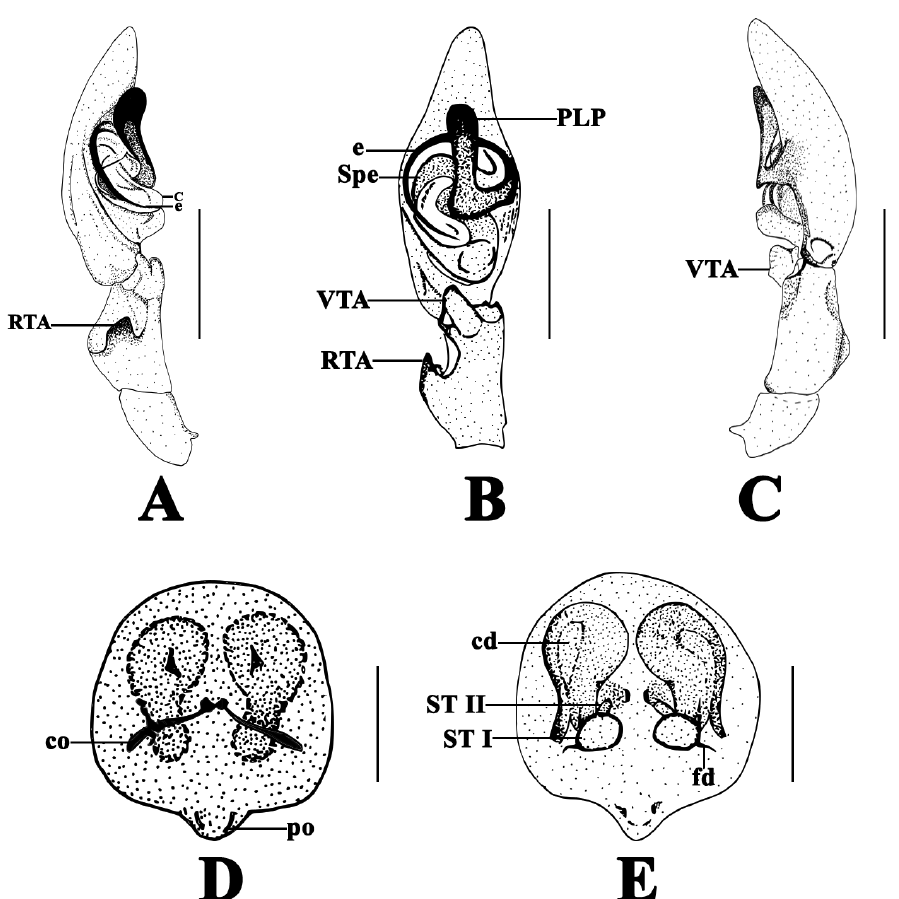
Figure 2. P. julioblancoi sp. n., holotype male (ICN–Ar 8420) A left male palp, prolateral view B same, ven- tral view C same, retrolateral view; paratype female (ICN–Ar 8421) D epigyne, dorsal view E same, ventral view. Abbreviations: c = conductor; cd = copulatory duct; co = copulatory opening; e = embolus; fd = ferti- lization duct; PLP = prolateral laminar process; po = epigynal; RTA = retrolateral tibial apophysis; sp = sper- mathecae; Spe = spermophore; VTA = ventral tibial apophysis. Scale bars 1 mm ( A–C ), 0.5 mm ( D–E